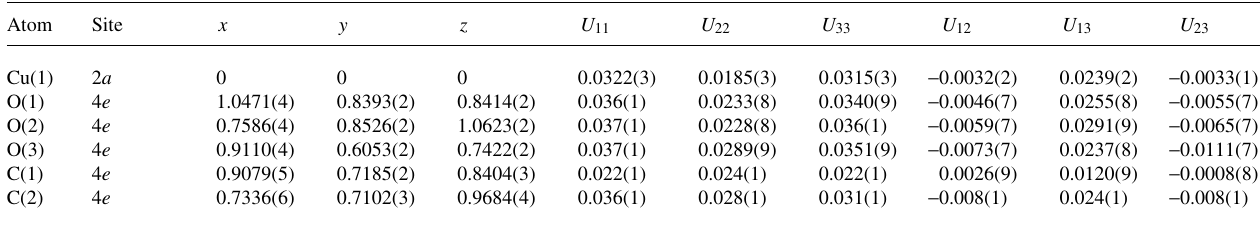
Table 3. Atomic coordinates and displacement parameters (in Å 2 )